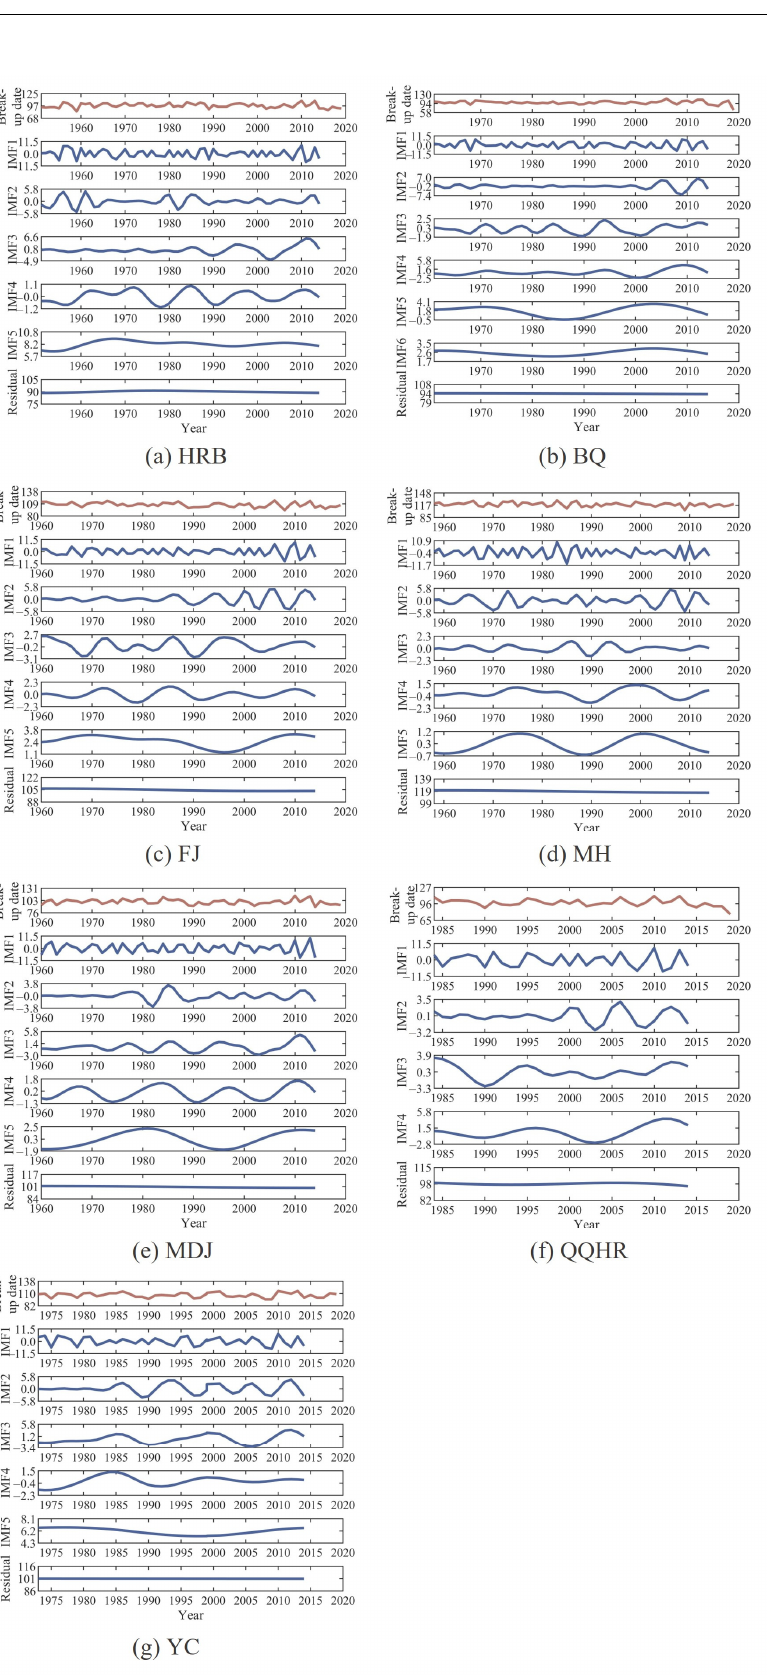
Figure 2. Observed break-up date series and decomposition results of CEEMDAN at each station in Heilongjiang Province (the unit of the break-up date is the “day”).